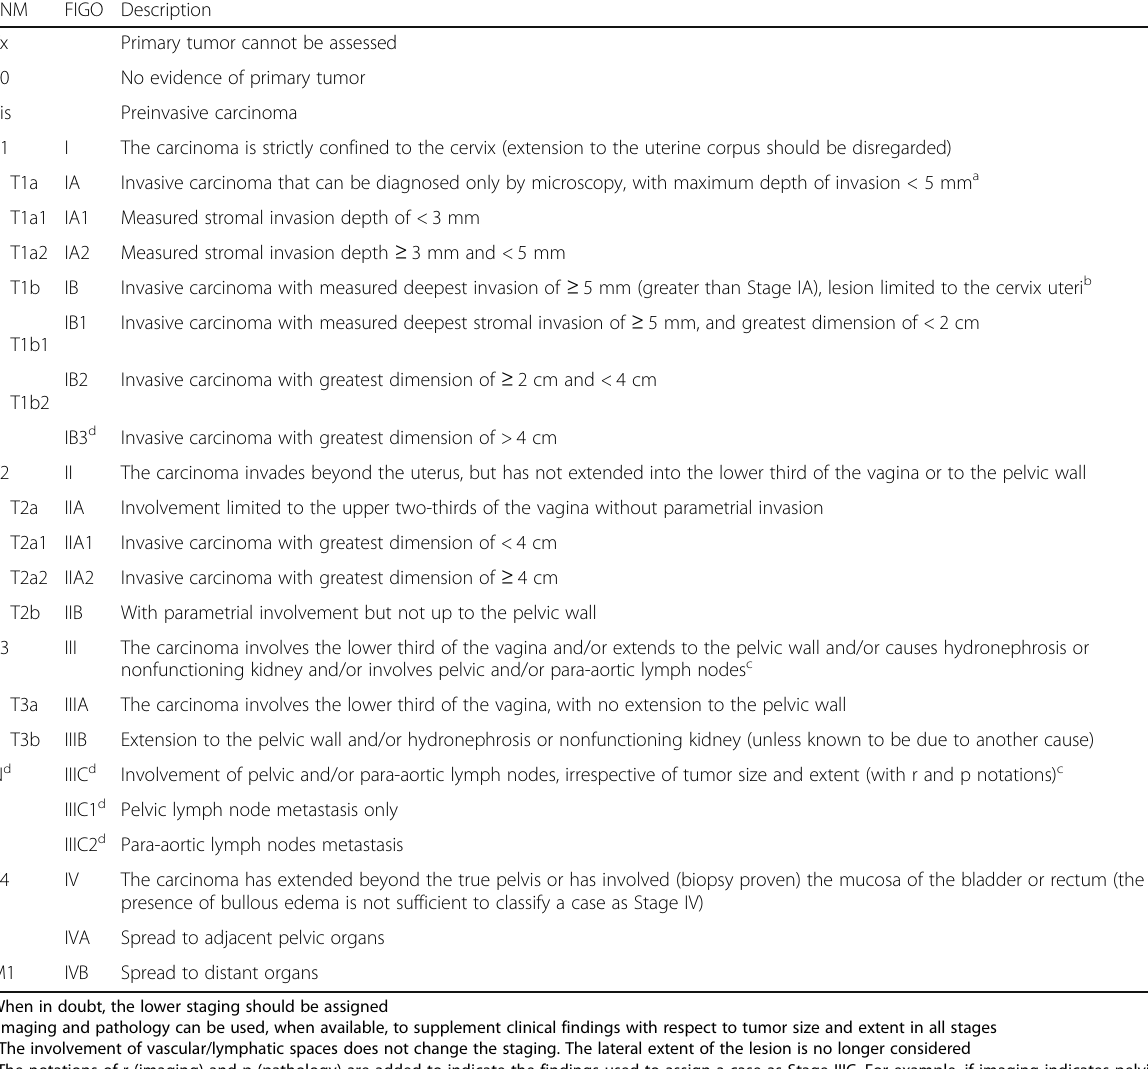
Table 2 TNM (8 th Edition) and FIGO (2018) Classification of cervical cancer (from refs. 26, 31) TNM FIGO